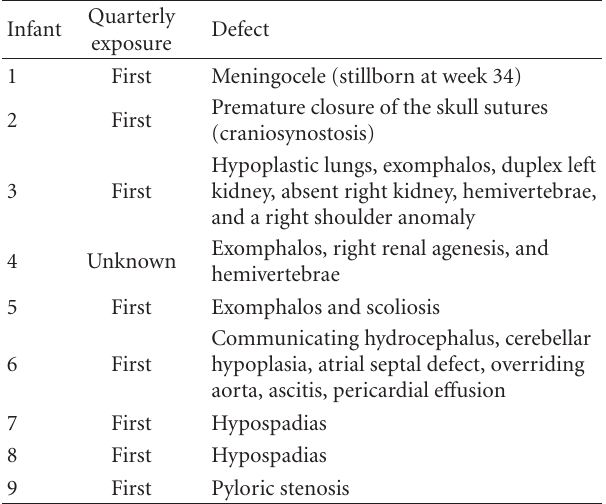
Table 1: Congenital defects in 9 infants borned after maternal expo- sure to